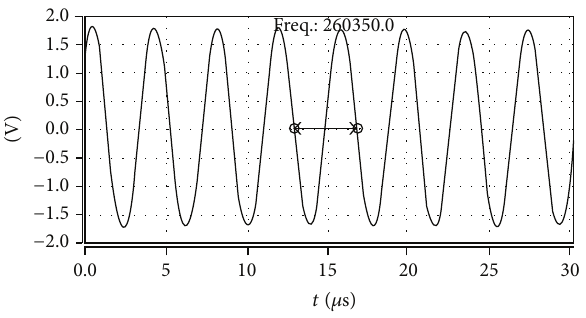
Figure 12: Simulation result of the highest applicable oscillation of the circuit (Figure